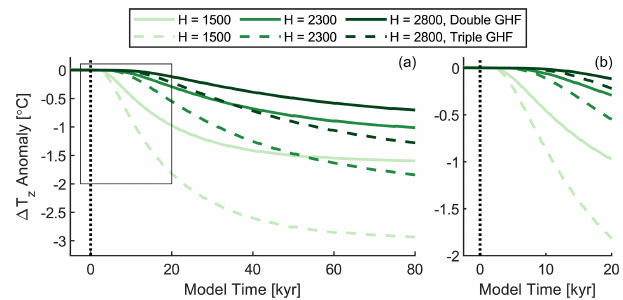
Figure 6. Modeled change in (cid:49)T z in response to a change in the basal geothermal heat flux (GHF), plotted as the difference from the value at t = 0. Solid lines correspond to experiments in which the GHF is doubled from 40 to 80Wm − 2 , and dashed lines cor- respond to experiments in which the GHF is tripled from 40 to 120Wm − 2 . Each experiment is repeated for three different ice thicknesses: 1500, 2300, and 2800m. The vertical black line in- dicates t = 0, the time at which the change in GHF occurs in the model. The box in (a) indicates the area covered by (b)